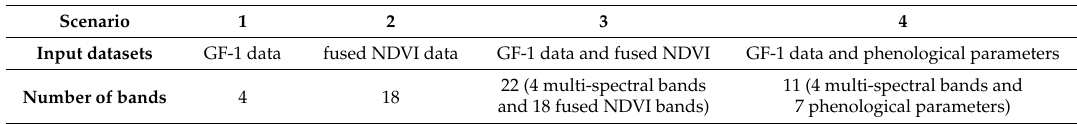
Table 3. The input datasets in the land cover classification